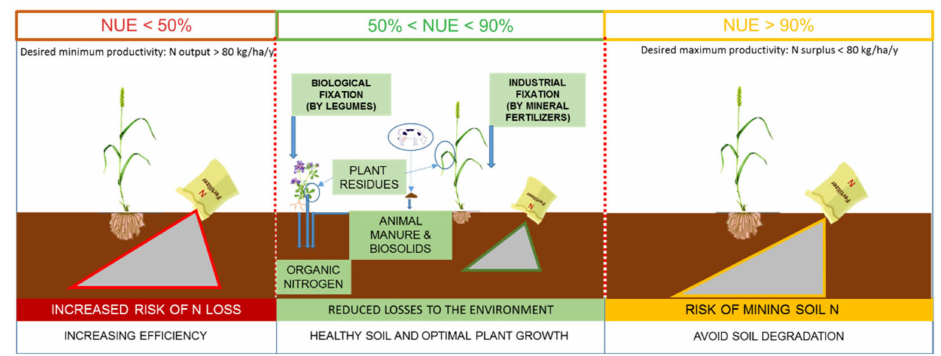
Figure 2. Ranges of desired NUE values